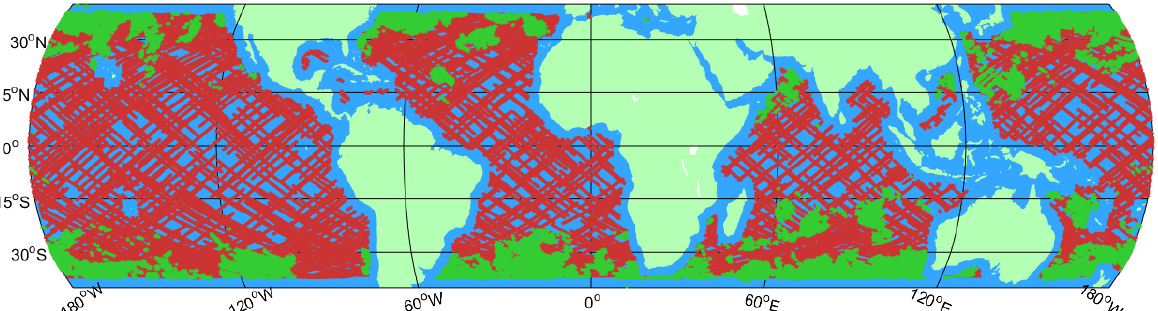
Figure 3. The spatial distribution of all data used in this